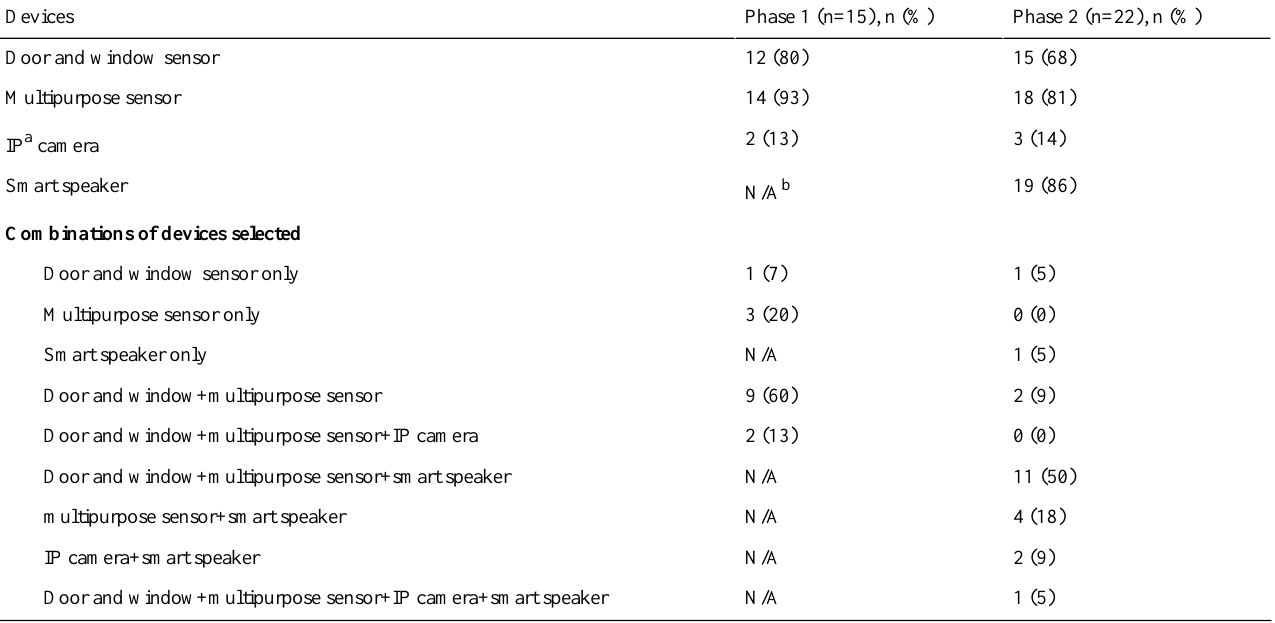
Table 3. Internet-of-Things device selection by the